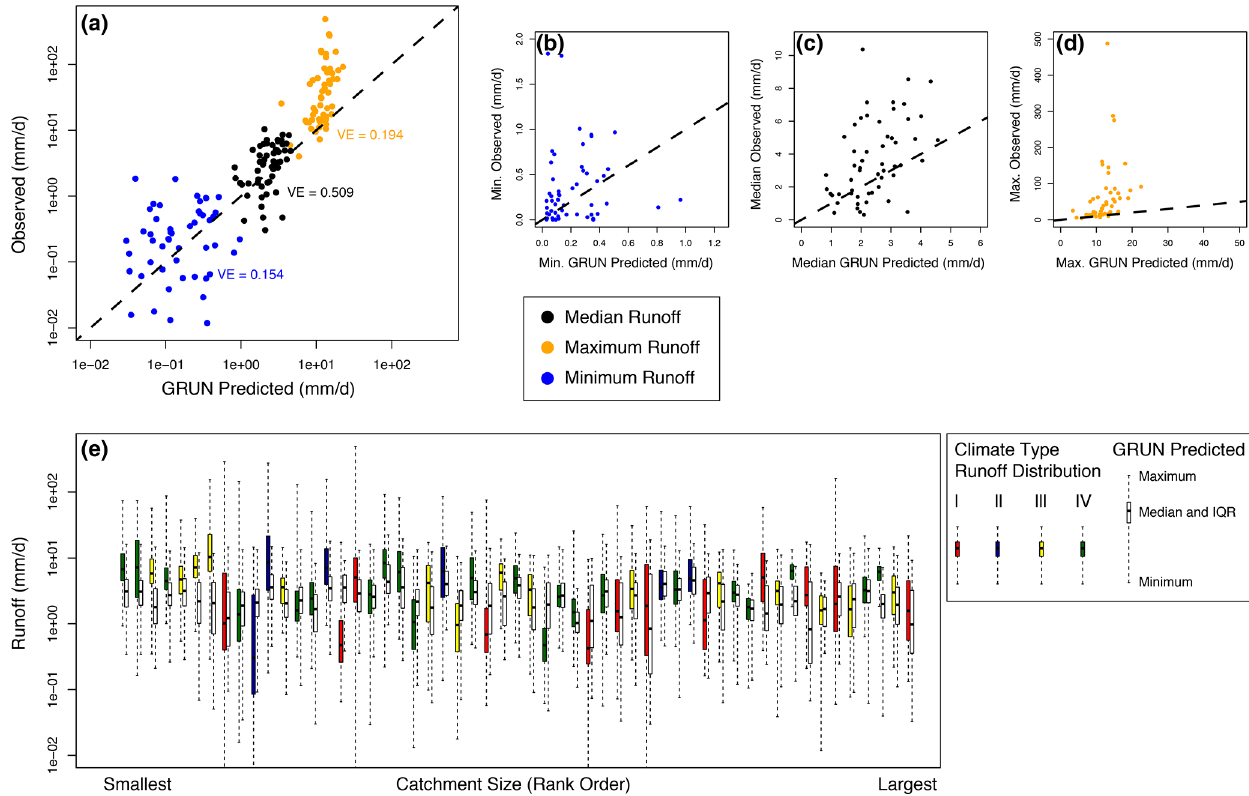
Figure 3. Comparison of runoff ranges and distributions. (a) Comparison of median and extreme (maximum and minimum) monthly runoff for the observations and GRUN in log space. (b–d) As in (a) for the minimum, median, and maximum monthly values, respectively, in linear space. (e) Distribution of runoff – observations (colored) and GRUN (white) – for the individual catchments (ordered by size). Plots show the median (line), interquartile range (box), and maximum and minimum values (whiskers). The boxplots for GRUN also only include months for which observations are